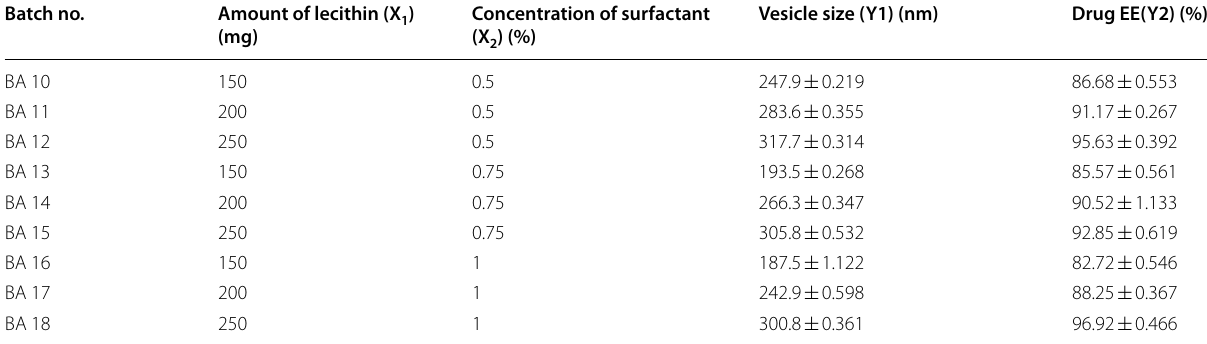
SD, where n (Mean ± Table 6 Check-point batch analysis Check‑ point